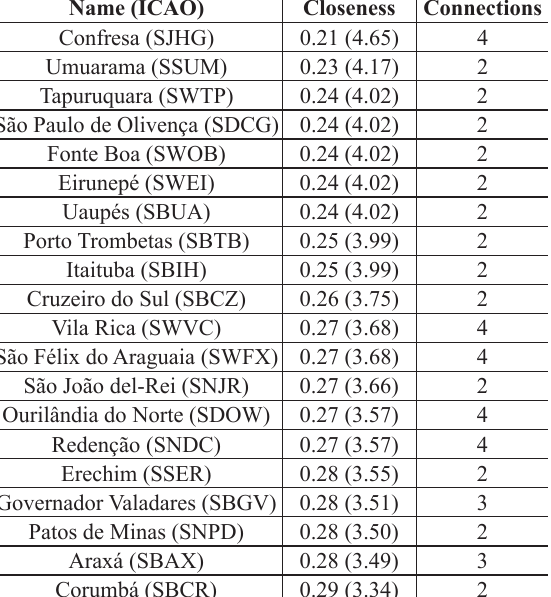
The 20 airports with the lowest closeness centrality